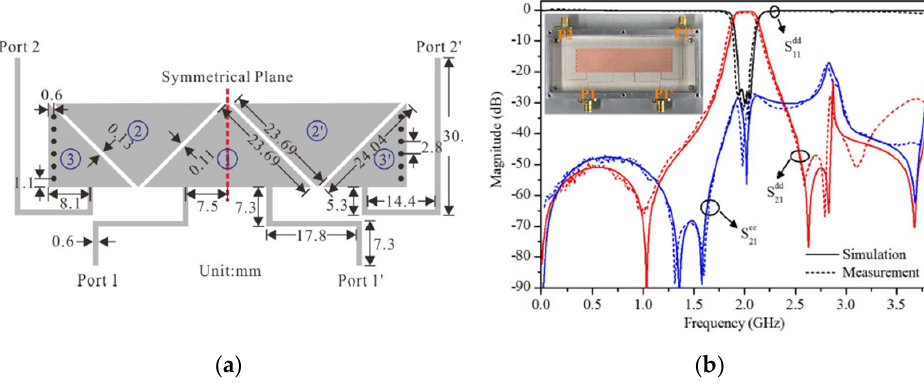
Figure 6. The proposed microstrip balun BPF [46]: ( a ) Photograph of the prototype; ( b ) S-parameter performance.